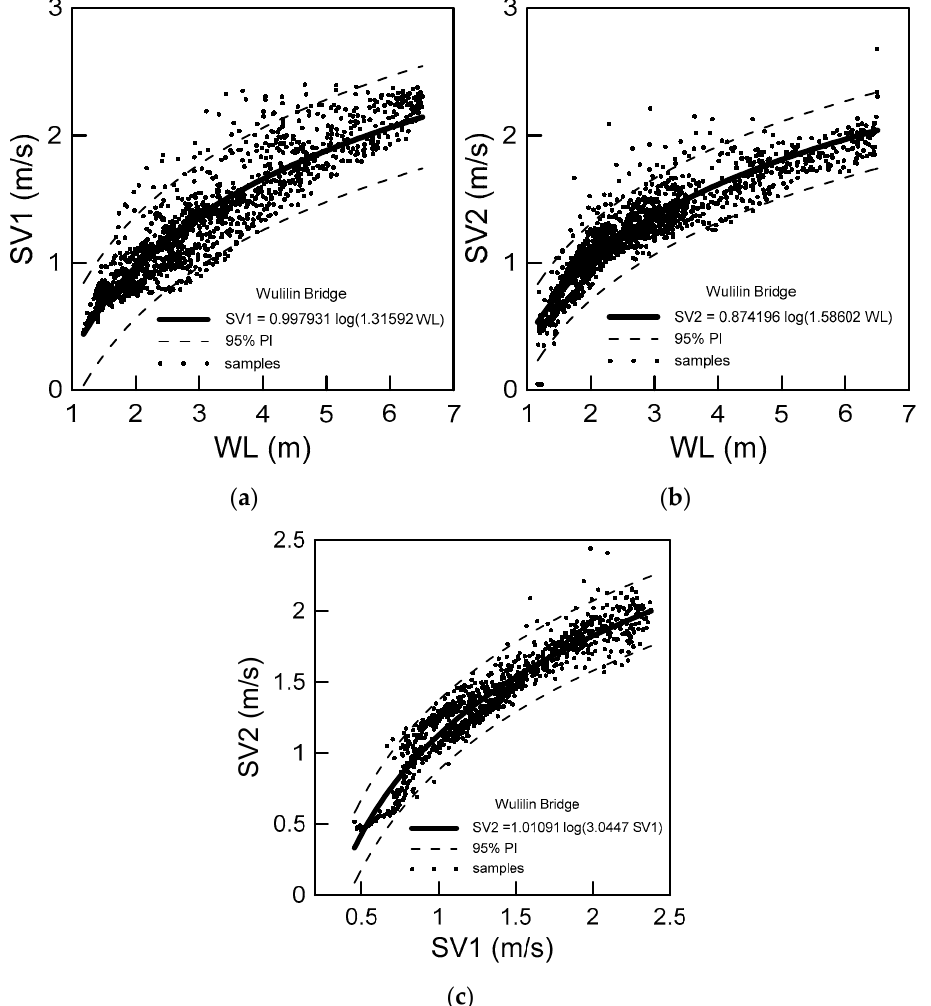
Figure 8. Data distribution and its regression result: ( a ) SV1 versus WL; ( b ) SV2 versus WL; ( c ) SV2 versus SV1. Water 2019 , 11 , x FOR PEER REVIEW